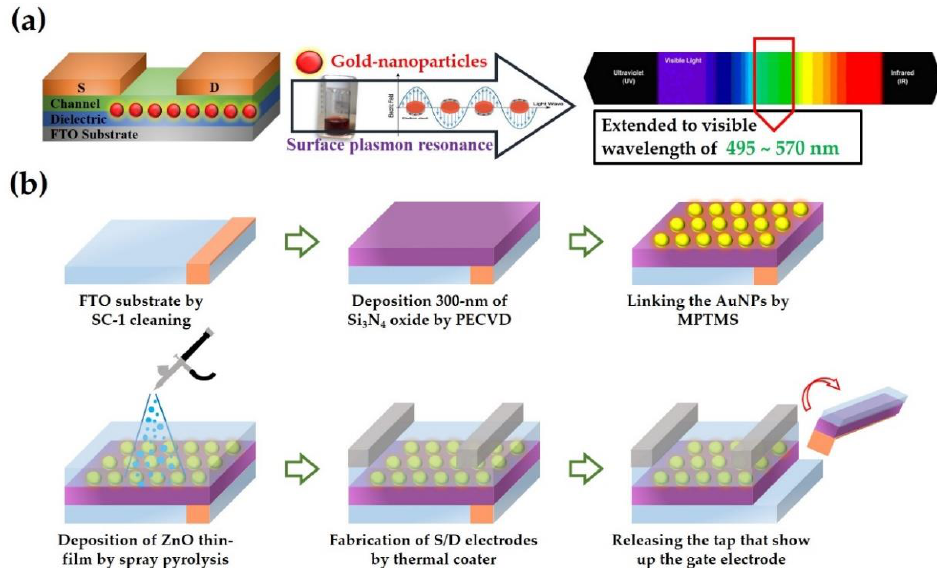
Figure 1. Photodetector with ZnO-based thin-film transistors (TFTs) and gold nanoparticles (AuNPs) fabricated on a transparent fluorine-doped tin oxide (FTO) structure. ( a ) Schematic and illumination of the photodetector. ( b ) Fabrication procedure of the photodetector with ZnO-based TFTs through spray pyrolysis processing. Plasma-enhanced chemical vapor deposition (PECVD).